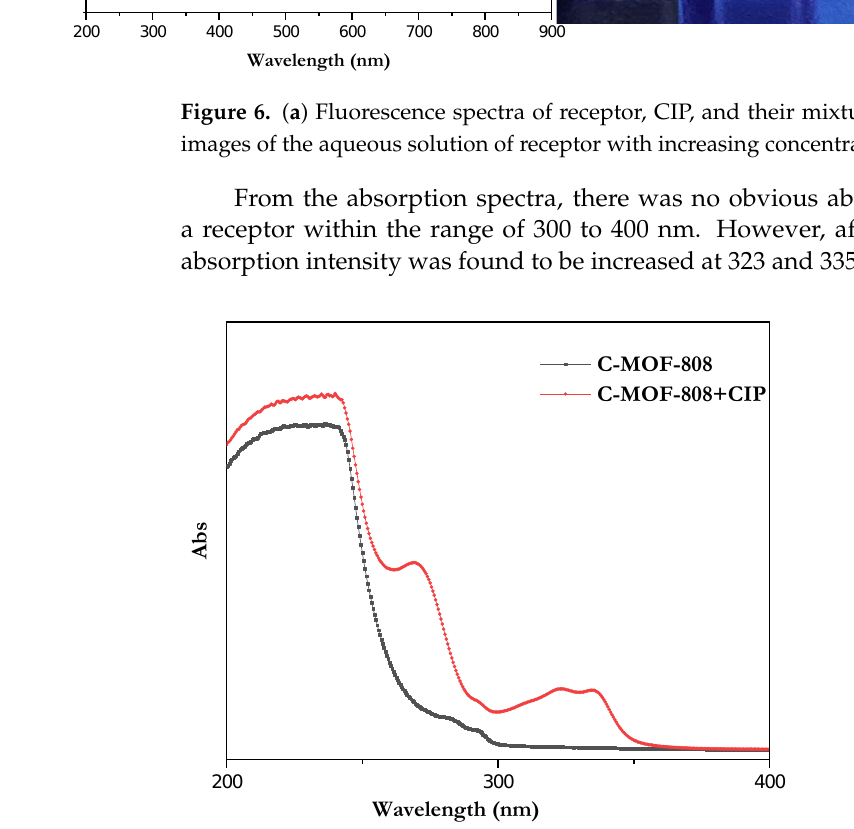
Figure 7. The absorption spectra of receptor and with CIP.